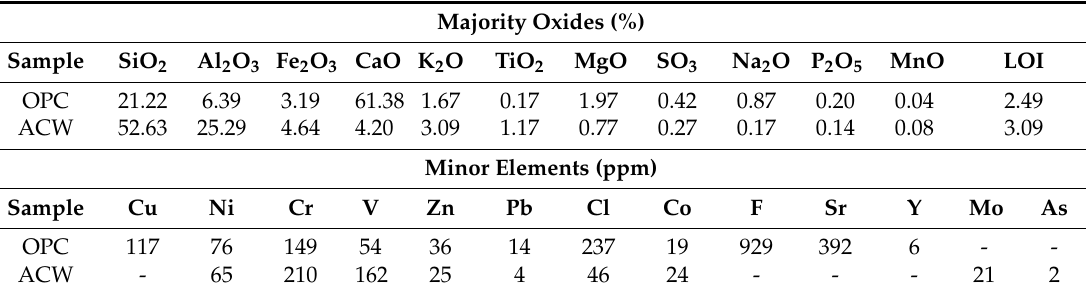
Table 1. Chemical composition of starting